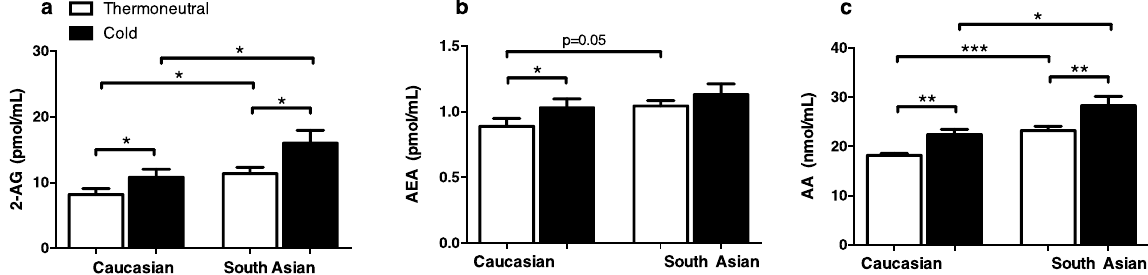
Figure 1. Circulating endocannabinoid levels are higher in South Asians and increased after short-term cooling. Blood was collected from healthy young South Asian (n = 10) and matched white Caucasian (n = 10) individuals before (thermoneutral) and after short-term mild cooling (Cold). Liquid chromatography coupled with tandem mass spectrometry (LC-MS/MS) was used to measure plasma concentrations of 2-AG ( a ), AEA ( b ), and AA ( c ) concentrations. Values are mean ± SEM. * P < 0.05, ** P < 0.01, *** P < 0.001. P-values are based on paired t-tests (effect of cold) or unpaired t-tests (effect of